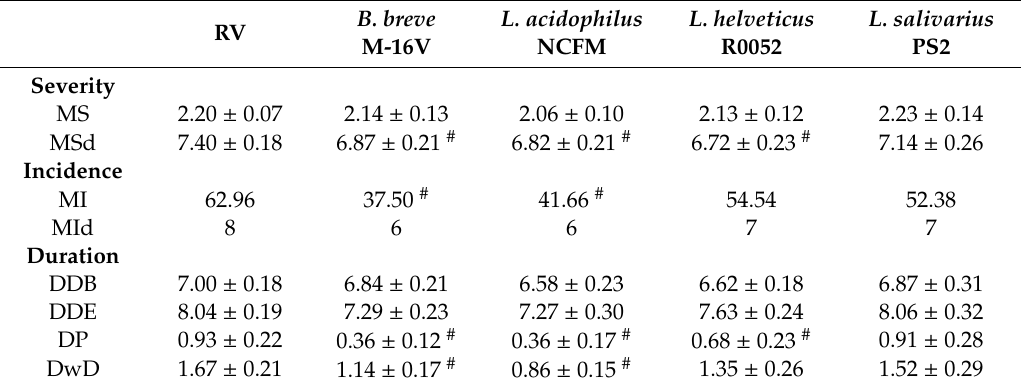
Table 2. Variables describing severity, incidence and duration of